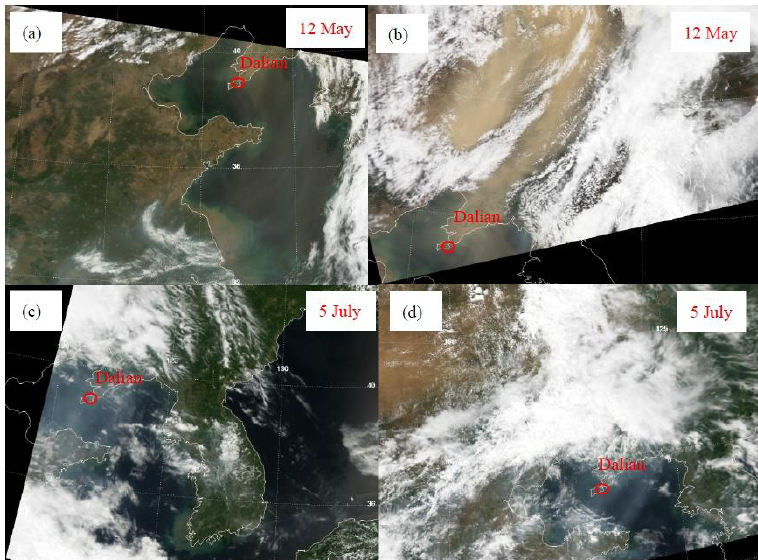
Figure 9. MODIS satellite images at the time of the Terra satellite overpass at 10:30 (local time) and the Aqua satellite overpass at 13:30 (local time), respectively over Dalian monitoring station for dust events on 12 May 2011 of ( a ) Terra images and ( b ) Aqua images and for fog events on 5 July 2011 of ( c ) Terra images and ( d ) Aqua images.